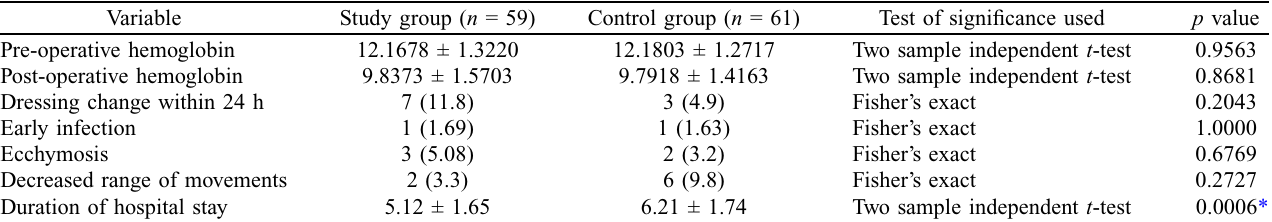
Table 1. Different variables like hemoglobin (Hb), dressing change, early infection, ecchymosis, decreased range of movements, and duration of hospital